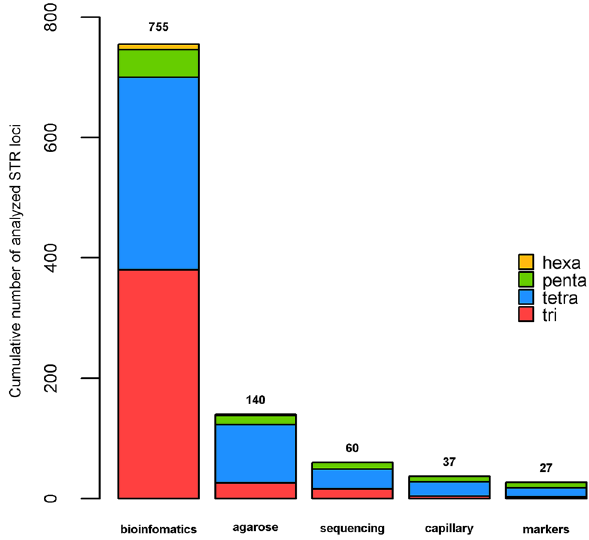
Figure 1. Overview of marker development. Tri to hexa refers to the proportion of tri- to hexanucleotide microsatellites. Created in R v4.0.3 (https:// cran.r- proje ct. org/) 23